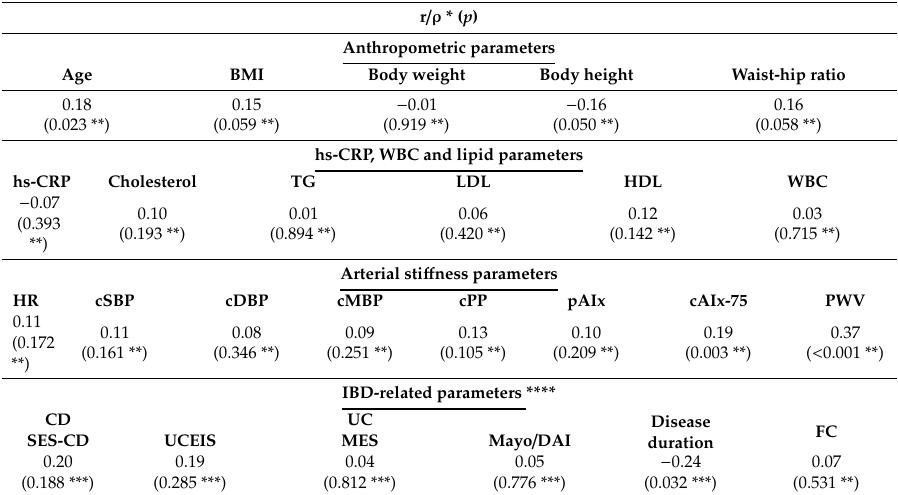
Table 5. Correlation between parameters of CTS and selected parameters. r / ρ * ( p )